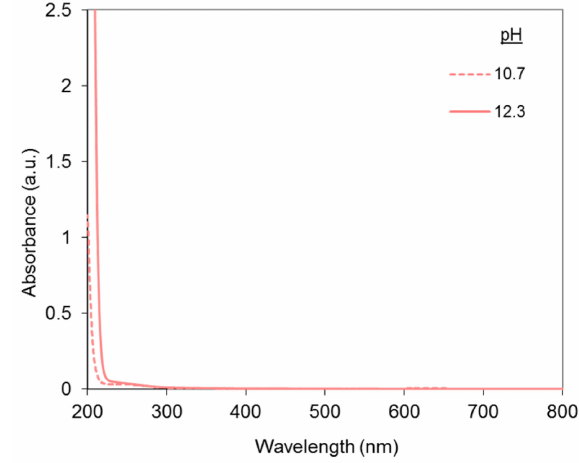
Figure 5. Absorbance spectra of copper sulfate solutions at pH 10.7 and 12.3, with [CuSO 4 ] = 15 µ